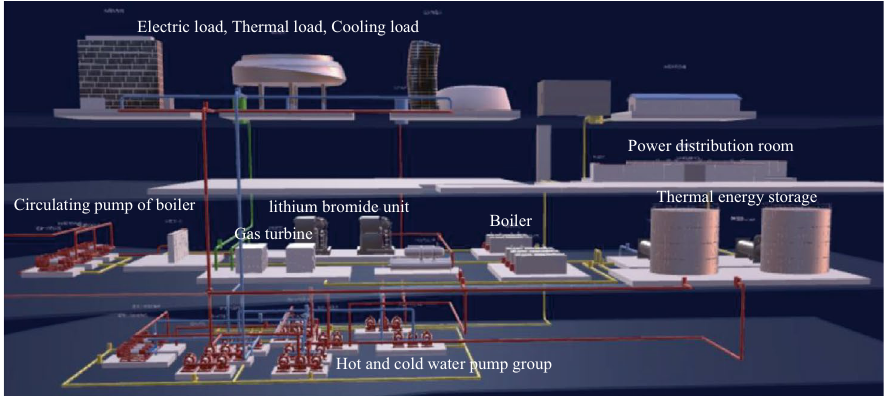
Figure 1. The energy station system in central south of China.